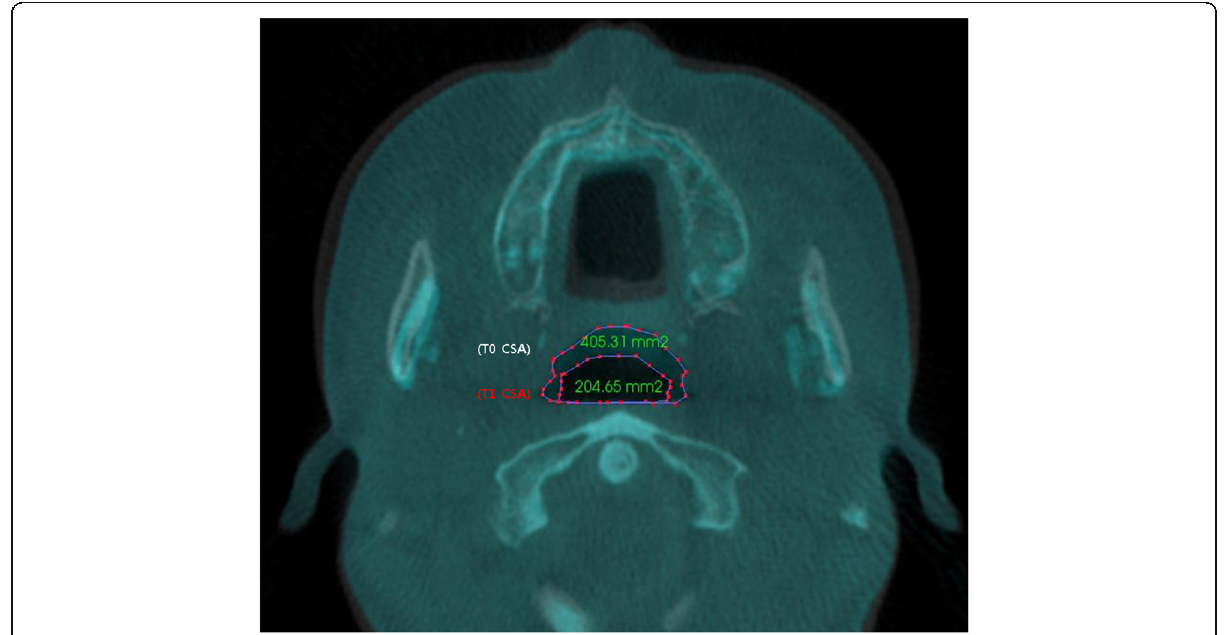
Fig. 3 Evaluation of the pharyngeal airway changes. Cross-sectional area ( CSA ) on each axial plane (CV1, CV2, CV3) were measured at T0 and